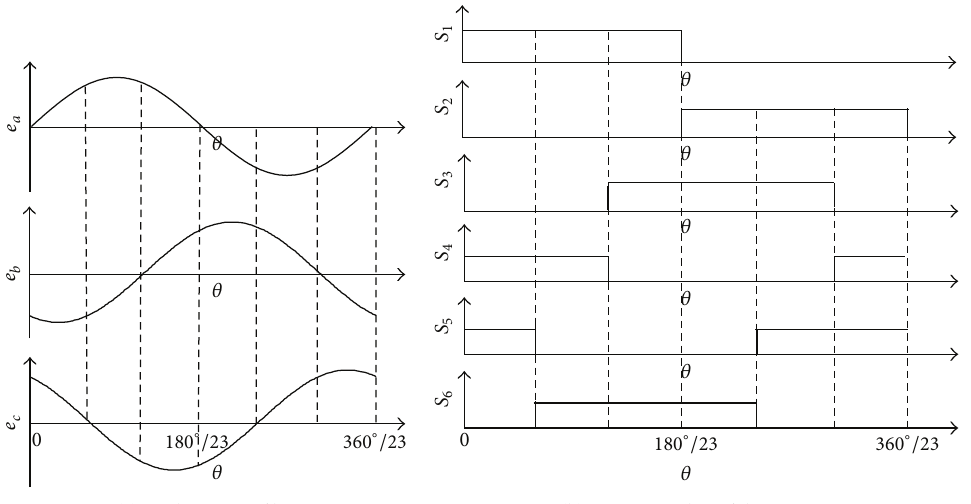
Figure 6: System configuration.